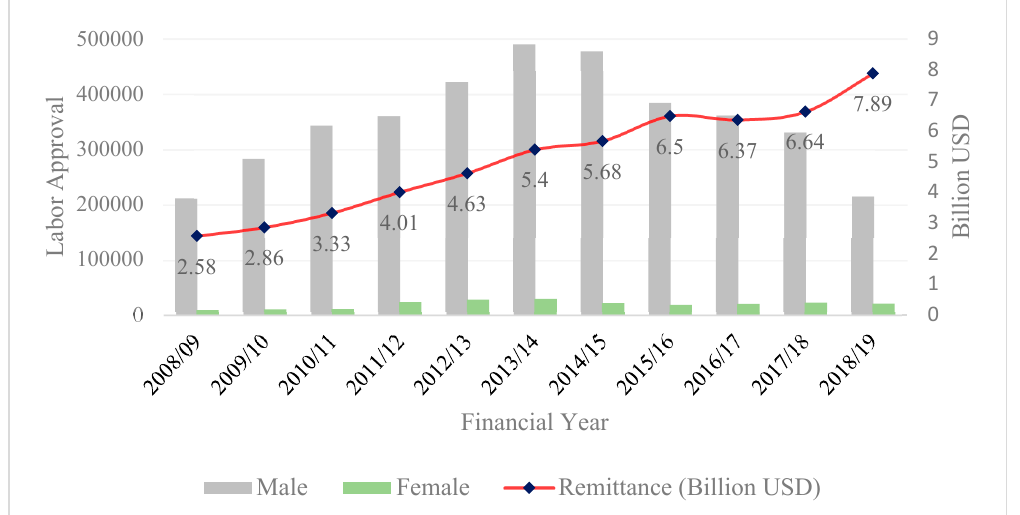
Figure 1. Trend in labor approvals (left Y -axis) issued by Department of Foreign Employment (DOFE) disaggregated by gender and incoming remittance (Right Y -axis) in Nepal. The figure does not include the number of workers migrating to the Republic of Korea through the government-to- government Employment Permit Scheme (EPS) and the migrants to India, as they do not require a work permit. Data shown in the graph were acquired from Foreign Employment Information Management System (FEIMS) of Nepal and the World Bank database.